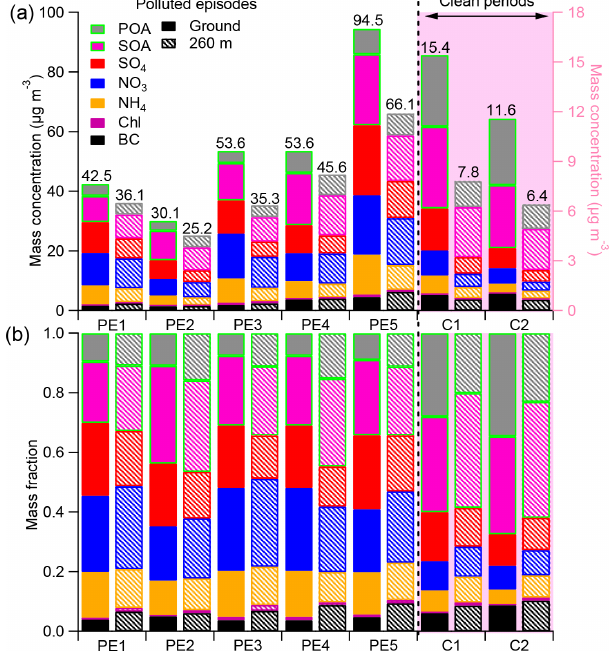
Figure 11. Average composition of PM 1 : (a) mass concentrations and (b) mass fraction during the five polluted episodes (PE1, PE2, PE3, PE4 and PE5) and two clean periods (C1 and C2) at 260m and at ground